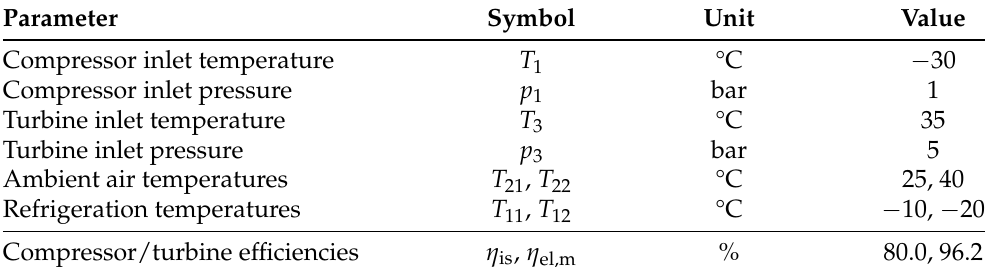
Table 8. Air refrigeration cycle—Parameters of the overall process and components [76].